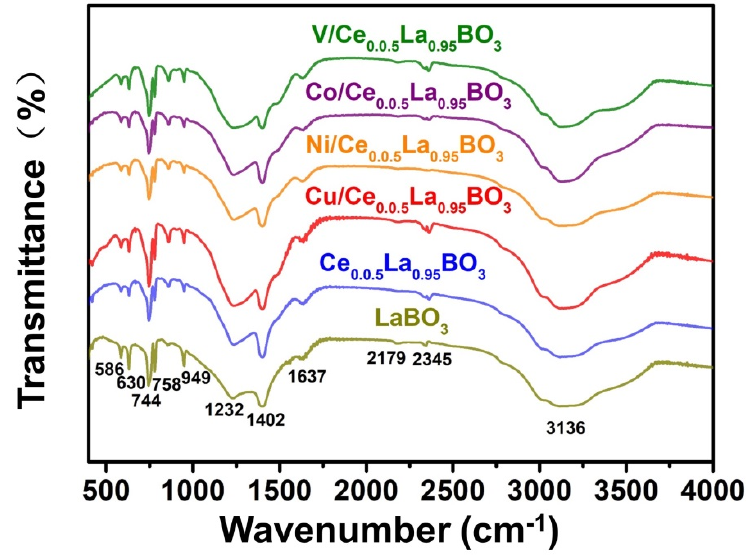
Figure 3. IR spectra of Cu/Ce 0.05 La 0.95 BO 3 , V/Ce 0.05 La 0.95 BO 3 , Co/Ce 0.05 La 0.95 BO 3 , Ni/Ce 0.05 La 0.95 BO 3 , Ce 0.05 La 0.95 BO 3 , and LaBO 3 .